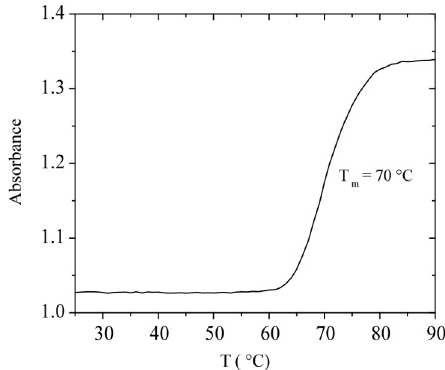
Figure 1. Temperature dependence of the absorbance at 260 nm of calf-thymus DNA (0.042 mg/mL) in TE buffer at pH = 7.3.